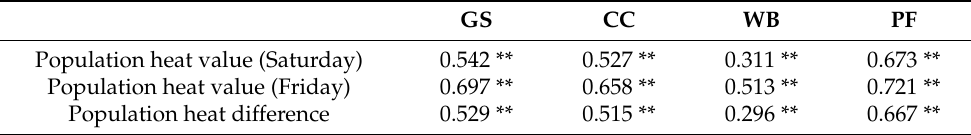
Table 4. Pearson correlation analysis.